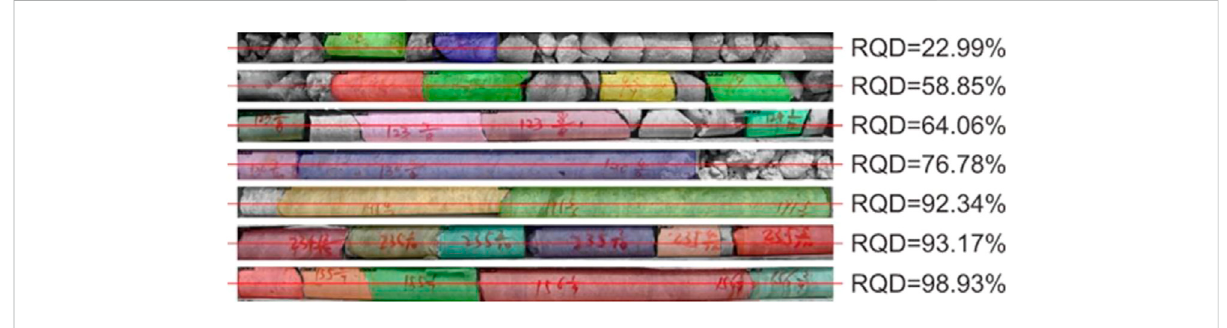
FIGURE 3 Automatic identi fi cation of RQD based on core digital image.